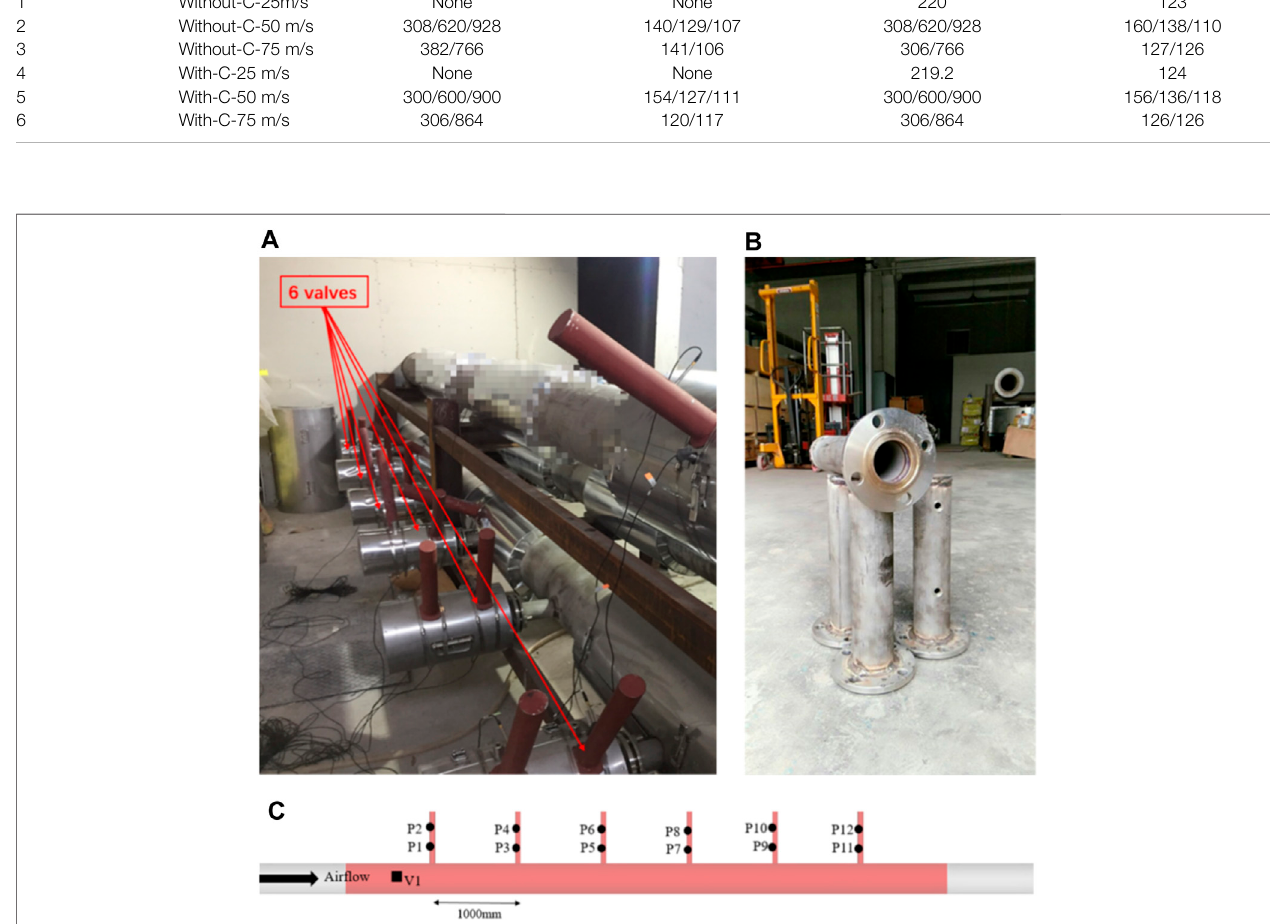
FIGURE 8 | The noise test of the resonant pipeline-cavity system: (A) Six pipe valves; (B) microphone location in the test; (C) sound pressure monitors in acoustic model.